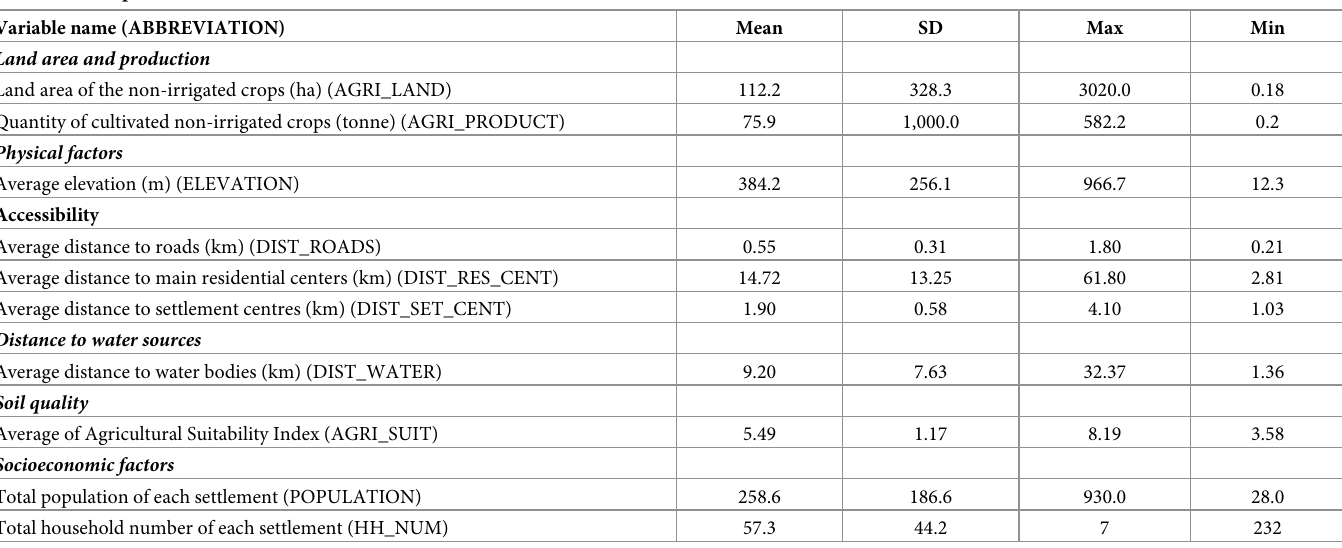
Table 1. Descriptive statistics of the variables.